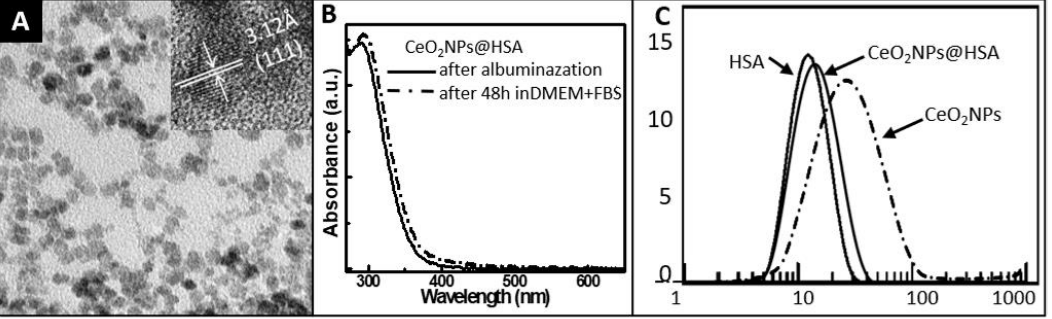
Figure 1. CeO 2 NPs characterization. ( a ) Transmission electron microscopy (TEM) and high-resolution transmission electron microscopy (HR-TEM) (inset) showing the as-synthesized cerium oxide (CeO 2 ) nanocrystals of 4±1 nm; ( b ) UV-VIS spectroscopy of CeO 2 NPs after conjugation to Human Serum Albumin (HSA) (CeO 2 NPs@HSA) and the same nanoparticles (NPs) after 48 hours in model physiological media (DMEM + Fetal Bovine Serum at 10% v/v). The similar spectra through time shows the stability in the physiological media of the NPs used; ( c ) Dynamic light scattering (DLS) of CeO 2 NPs as synthesized, HSA, and CeO 2 NPs@HSA. While the spectrum of CeO 2 NPs shows a large presence of agglomerated NPs, the similar spectra of HSA and CeO 2 NPs@HSA rules out the presence of CeO 2 aggregates. Note, that all samples have been purified before measurement.